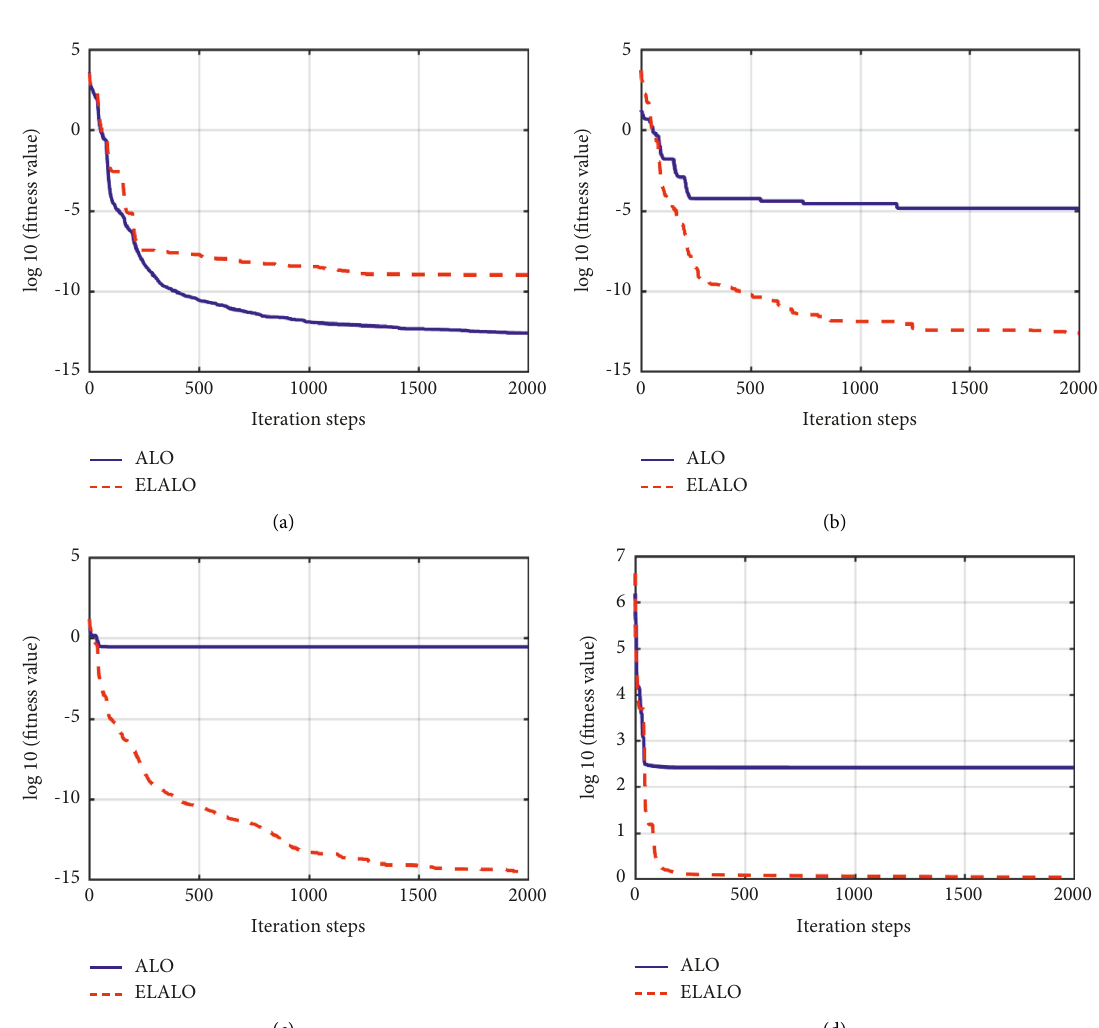
Figure 6: Comparison of convergence curve. (a) Curve comparison on F (d) curve comparison on F 4 .